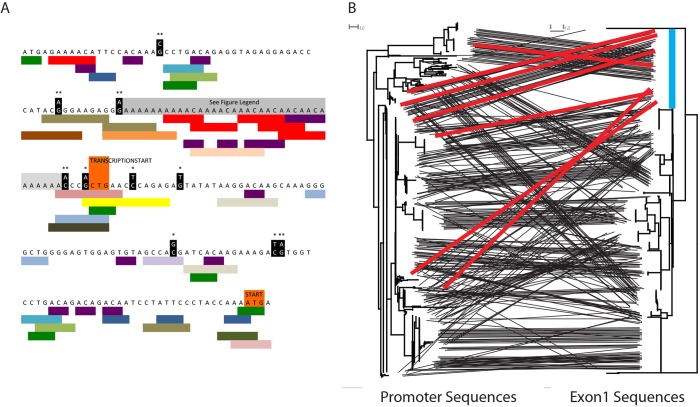
Variants immediately upstream of the start codon associated with expression.(A) Multiple variants immediately upstream of the start codon are significantly associated with reduced expression or silencing of genes. Variants significantly associated with reduced expression at P < 0.05 are highlighted in black (* < 0.05, ** < 0.01). Colored bars beneath the sequence are transcription factor binding site motifs, with each color denoting a different transcription factor. The adenine rich region shaded in grey has many substitution and indels found among promoter sequences in this study. Examples of the variants can be found in S3 Fig and have not been shown here because the poor alignment of sequences in this region complicates the associations of mutations at particular sites with expression data. (B) The tanglegram shows the relationship between promoter sequences and exon 1 sequences. Each tree is a neighbor-joining tree and identical sequences of a given exon or promoter are shown with independent lines either because they occurred in different individuals or because they were associated with different partners. The blue line in the exon tree highlights an abundant exon 1 sequence that is paired with divergent promoter sequences. The red lines show some of the connections between the blue-highlighted exon sequence and its promoters. The fact that a single exon sequence is associated with divergent promoter sequences is consistent with a history of recombination and gene conversion among the central Mup paralogs.